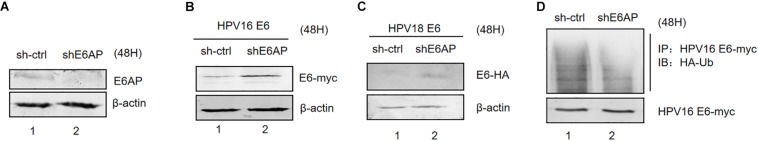
Effect of E6AP silencing on the stability of HPV E6. (A)
E6AP knockdown was confirmed by immunoblotting. (B) HEK293T cells (E6AP-null) were transfected with HPV16 E6 or HPV18 E6. (C) After 48 h the cells were harvested, and protein levels analyzed by immunoblotting. β-actin acted as a control for transfection efficiency. (D) HEK293T cells (E6AP-null) were transfected with the indicated expression plasmids; after 36 h they were treated with 10 μM MG132 and 12 h later, harvested and subjected to immunoprecipitation (IP) with anti-myc-conjugated agarose beads. Polyubiquitinated HPV E6 was then detected for IP with an antibody against HA.